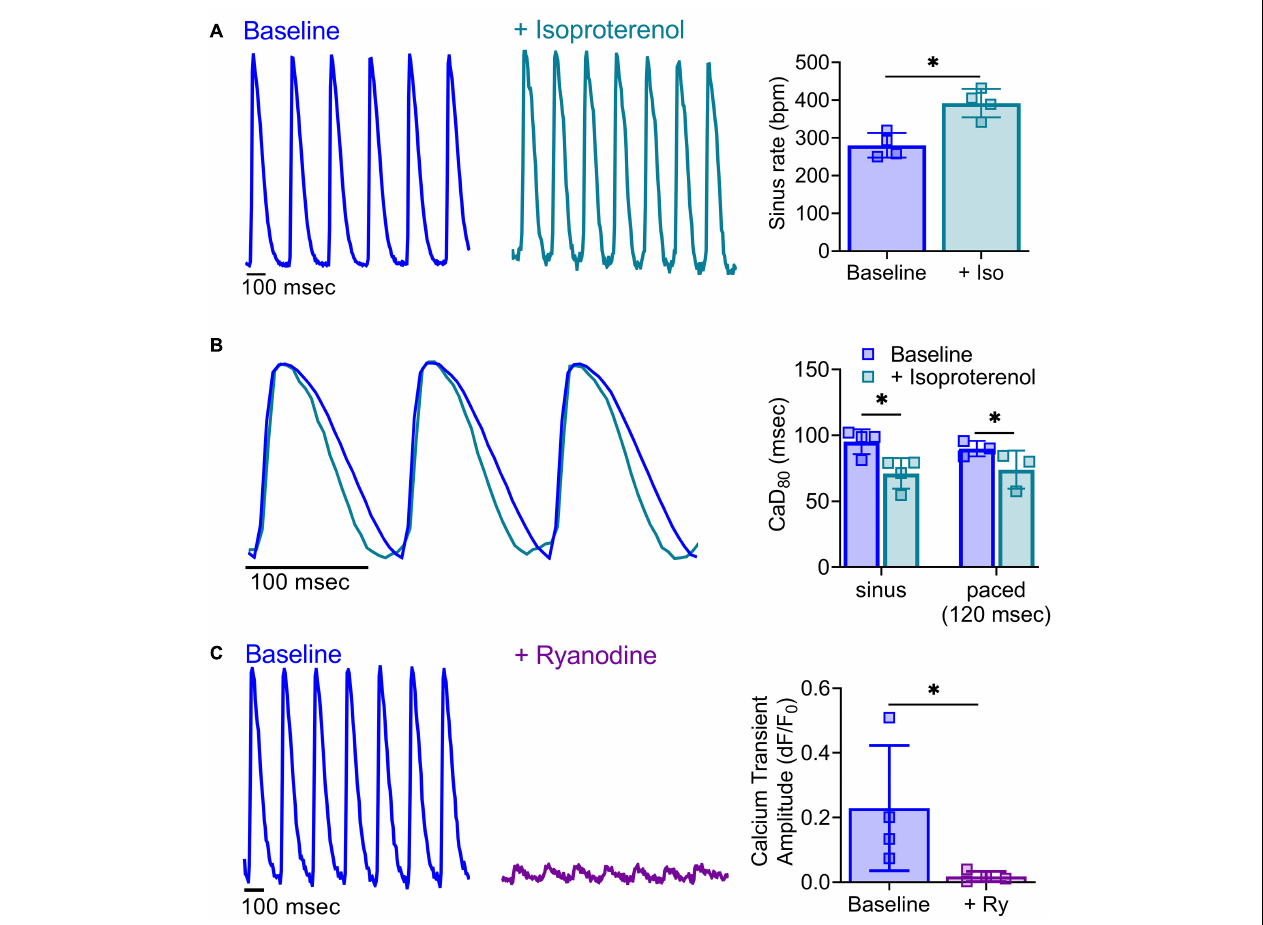
FIGURE 8 | Impact of pharmacological agents on calcium handling. (A) Representative calcium transients acquired from a Langendorff-perfused rat heart at baseline and after acute treatment with isoproterenol (30 nM). Isoproterenol increased sinus rate (right, n = 4 independent heart studies, * p < 0.05 as determined by two-tailed Student’s t -test). (B) Shorter calcium transient duration time in response to isoproterenol application was readily observable in calcium signals from a Langendorff-perfused rat heart during sinus rhythm and with external pacing for rate correction (120 ms PCL, n = 3–4 independent heart studies, * p < 0.05 as determined by two-way ANOVA with multiple comparisons testing). (C) Representative calcium transients from a Langendorff-perfused rat heart at baseline and after acute treatment with ryanodine (5 µ M), during external pacing (160 ms PCL). Ryanodine diminished calcium transient amplitude (right; n = 4 independent heart studies, * p < 0.05 as determined by two-tailed Student’s t -test). Values reported as mean + SD. BPM = beats per minute, dF/F0 = change in fluorescence over